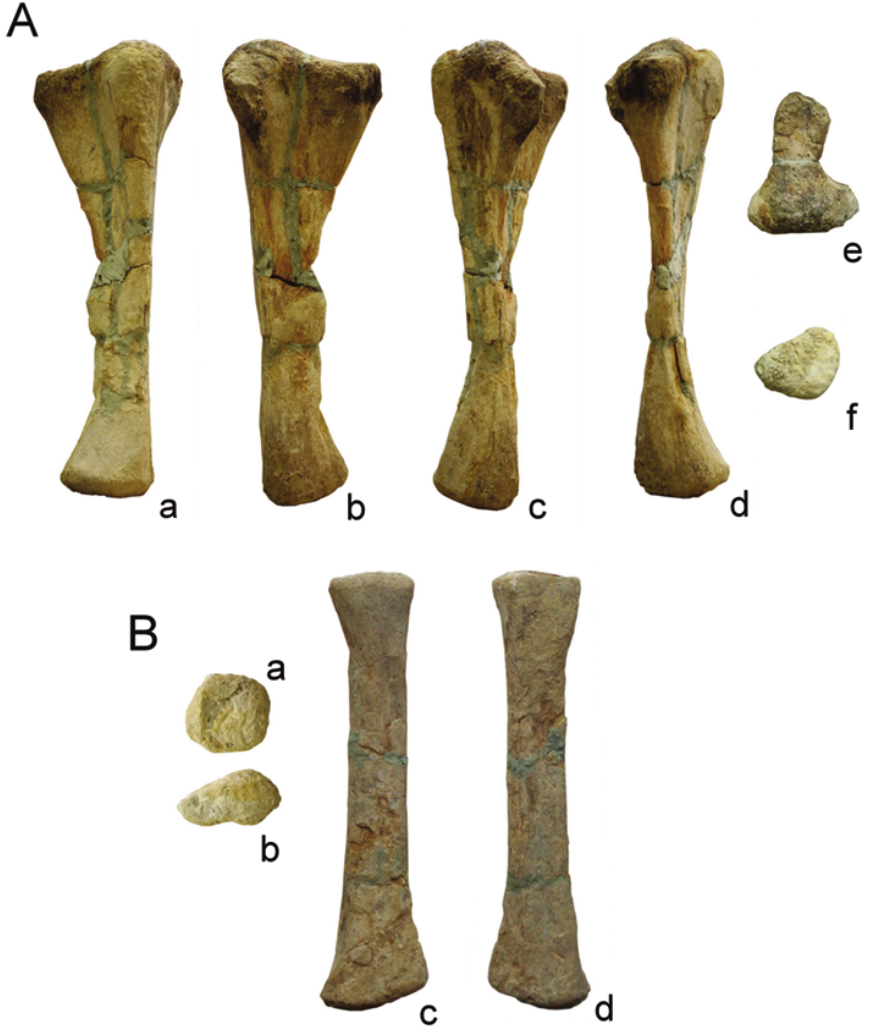
Fig. 4 – Angolatitan adamastor n. gen. et sp., A) right ulna in medial (a), anterior (b), lateral (c), posterior (d), proximal (e) and distal (f) views; and (B) right radius in proximal (a), distal (b), anterior (c), and posterior (d)